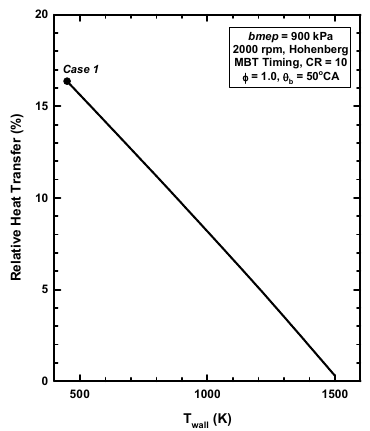
Figure 3. Relative heat transfer as a function of cylinder wall temperature for case 1.